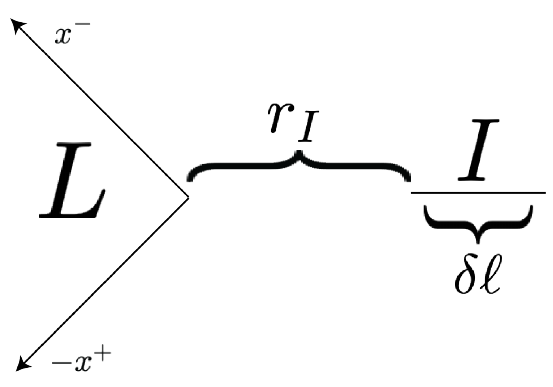
Figure 3 . The setup we consider in a 1+1 dimensional